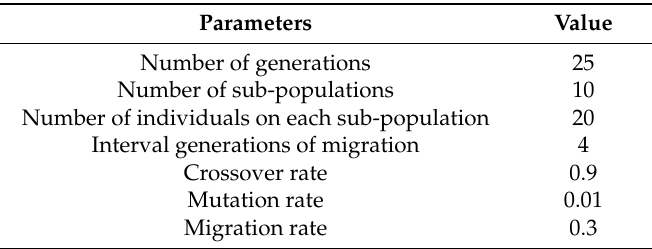
Table 1. Parameters of